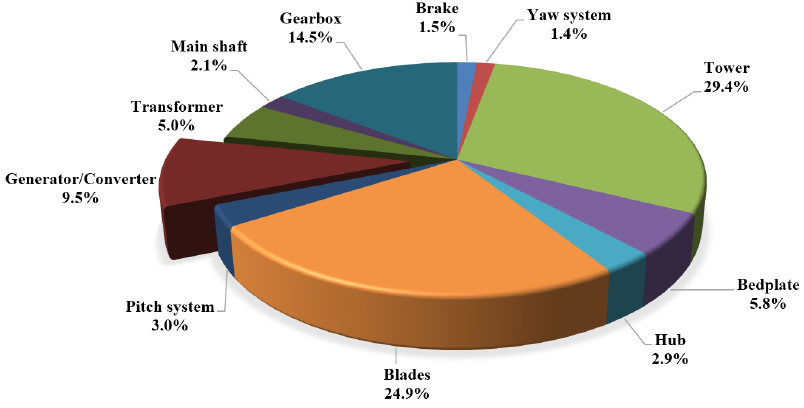
Figure 3. Distribution of the component costs for a typical 2 MW wind turbines (adapted from